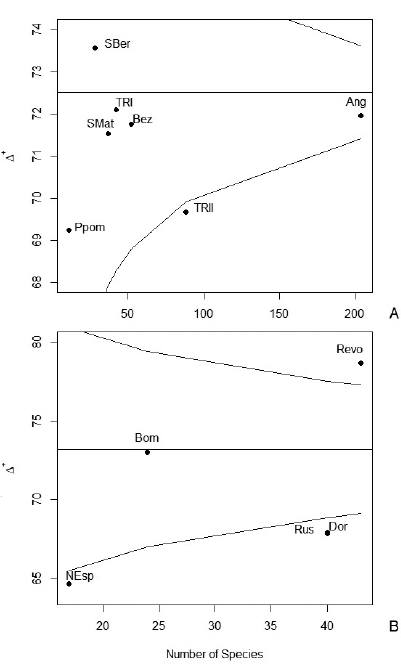
Figure 5. Taxonomic distinctness (TD) for caves from A São Domingos and B Posse karst areas. Horin- zontal line presents the expected TD for the region and funnel graph means 95% confidence limits. Legend: SBer= São Bernardo cave system, Ang= Lapa Angélica, Bez= Lapa do Bezerra, SMat= São Mateus cave system, TR_I= Terra Ronca I cave, TR_II= Terra Ronca II cave, PPom= Pau Pombo cave, Rus= Rus- são cave system, Bom= Bombas cave system, Dor= Doralino cave system, NEsp= Nova Esperança cave, Rev= Revolucionários